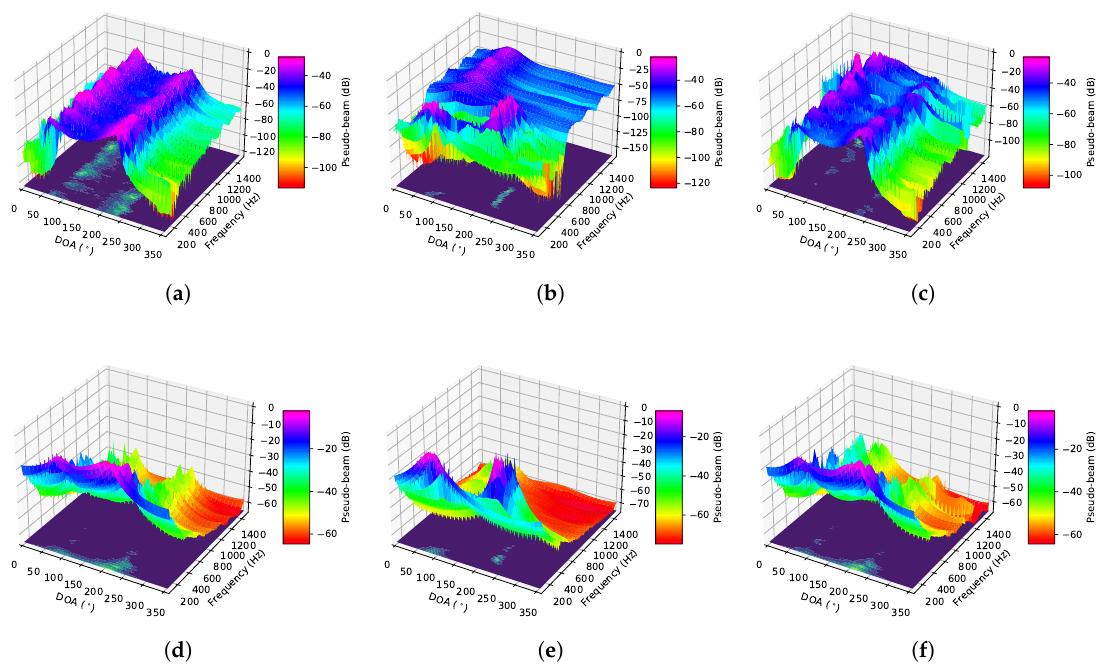
Figure 9. Space-frequency pseudo-spectra obtained by CFCN-DOA and CNN-DOA in the experiment in the semi-anechoic chamber. ( a ) CFCN under the overlapping low-frequency dual-source condition. ( b ) CFCN under the non-overlapping frequency dual-source condition. ( c ) CFCN under the overlapping full-frequency dual-source condition. ( d ) MUSIC under the overlapping low-frequency dual-source condition. ( e ) MUSIC under the non-overlapping frequency dual-source condition. ( f ) MUSIC under the overlapping full-frequency dual-source